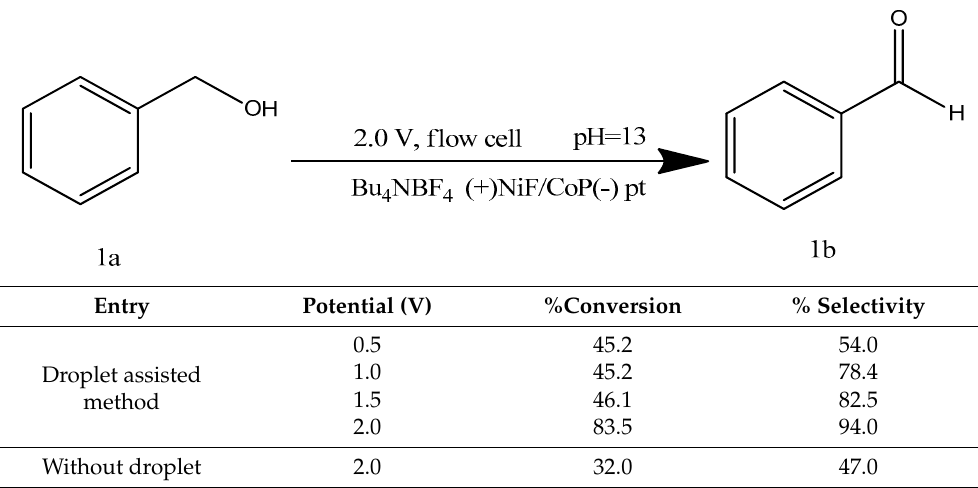
Table 1. Optimization of droplet-assisted electrochemical oxidation of benzyl alcohol *.